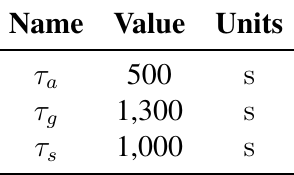
Table 2. Time constants.